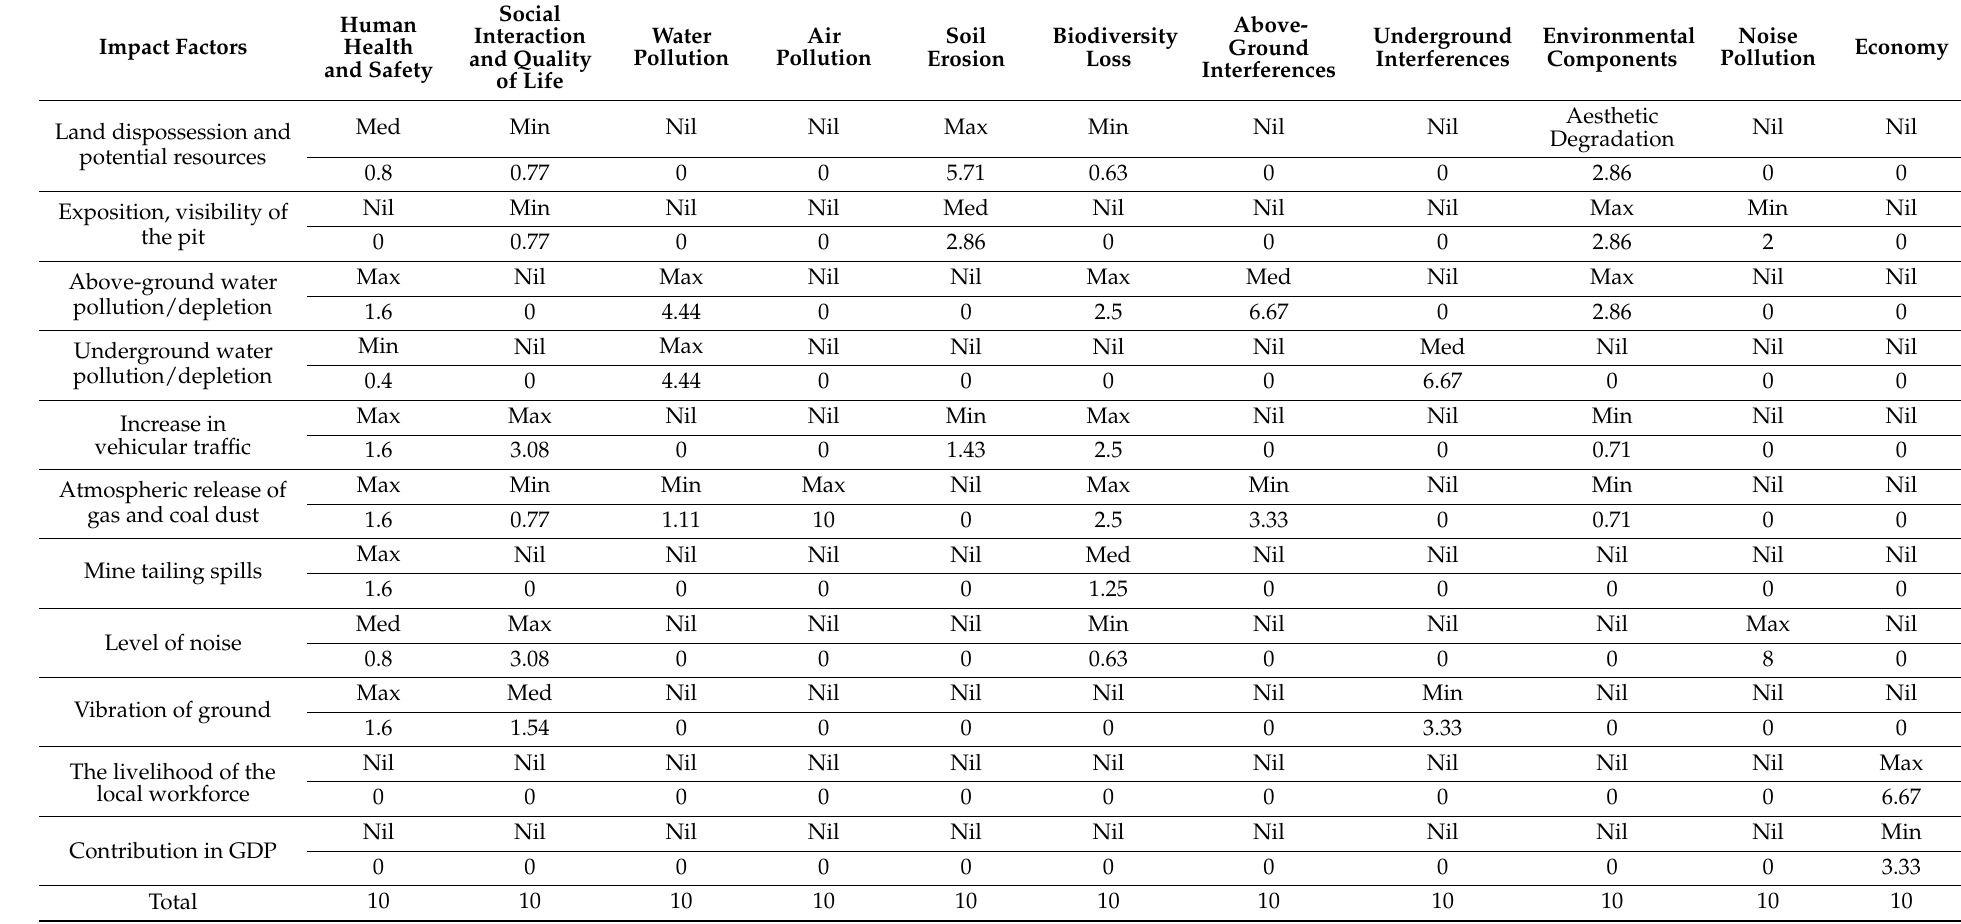
Table 3. The correlation matrix of impacting factors and component